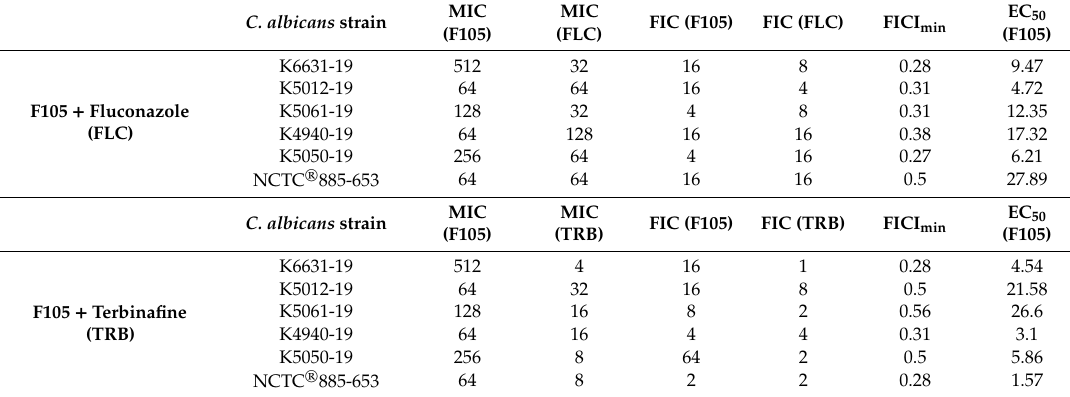
Figure 2. The EC 50 values of F105 leading to the 2-fold MIC reduction of fluconazole and terbinafine on di ff erent strains of C. albicans . Table 3. Synergistic effect of F105 with fluconazole and terbinafine on C. albicans strains. MIC and FIC are expressed in μ g/mL.